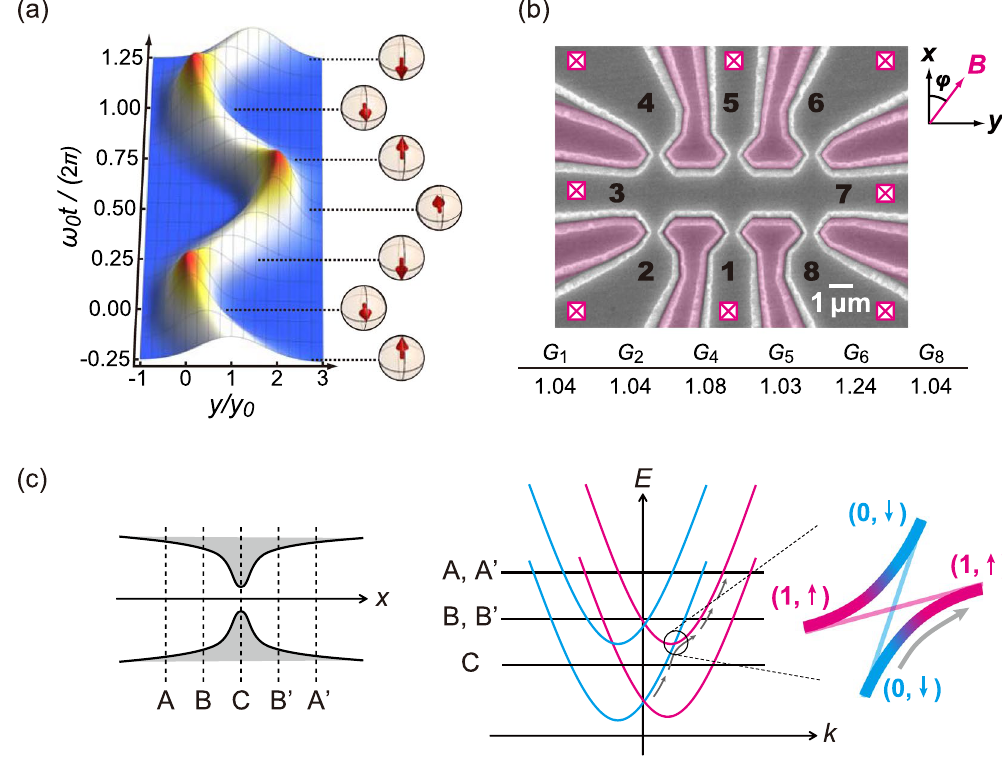
Figure 2. Experimental setup. ( a ) ZB in the Rashba model (for ω 0 and y 0 , refer to equation (2). An electron wave packet, with spin parallel to the z -axis and an averaged momentum along x at time t = 0, oscillates along the y -axis in synchrony with the rotating spin in the z – x plane. ( b ) Scanning electron micrograph of the sample with terminals marked. The pink false-colour areas act as gates isolated by trenches to define the QPCs. Conductance of each QPC is listed below the micrograph in units of G q ( T = 55mK). ( c ) QPC diagram (left) and dispersion curves for the one-dimensional bands with a Rashba SOI (right). Red and blue curves indicate spin up and spin down, respectively. The magnification of a crossing point reveals a small avoided crossing. Within the spatial movement from C to B, an electron experiences the avoided crossing where the spin is flipped from down to up. A, C, and B indicate the positions of the Fermi energy during traversals—at the outlet, at the middle, and at a point between them, respectively 19